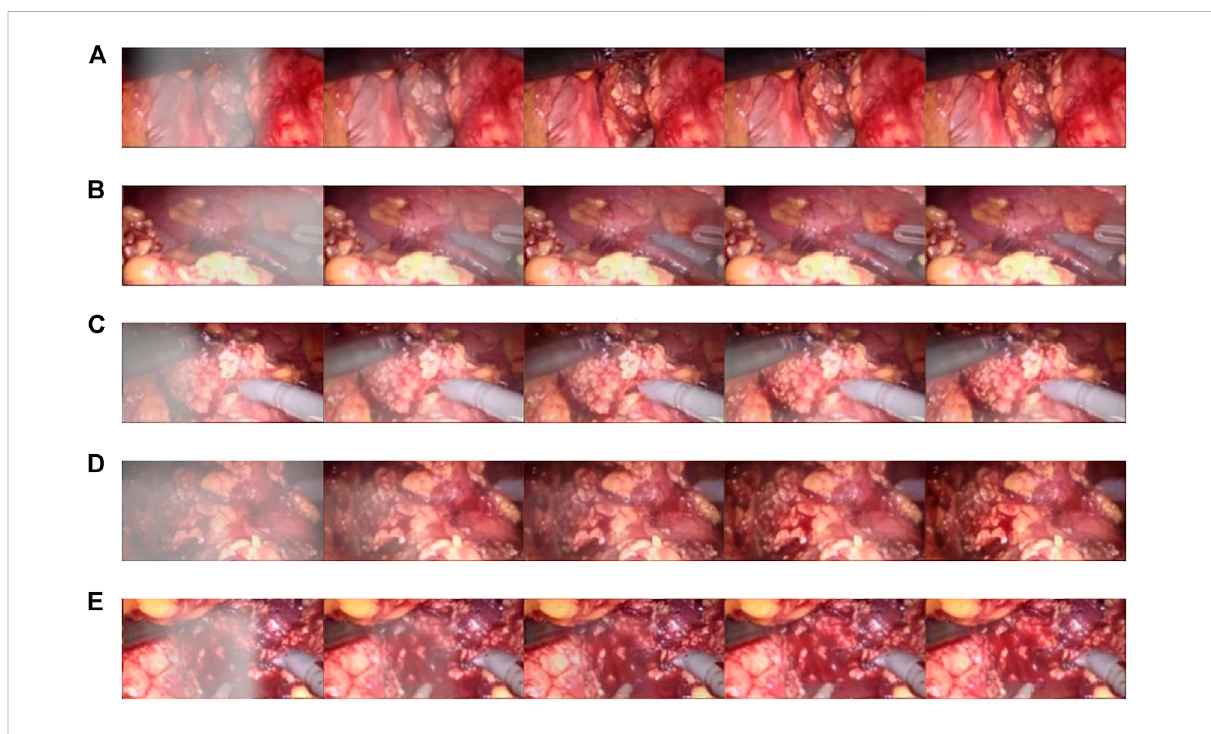
FIGURE 7 Synthetic smoke laparoscopic images and puri fi ed images. (A) Laparoscopic image with synthetic smoke and after puri fi cation; (B) Laparoscopic image with U-NET; (C) Laparoscopic image with U-NET + BAM; (D) Laparoscopic image with U-NET + Laplace; (E) Laparoscopic image with U-NET + CBAM + Laplace.